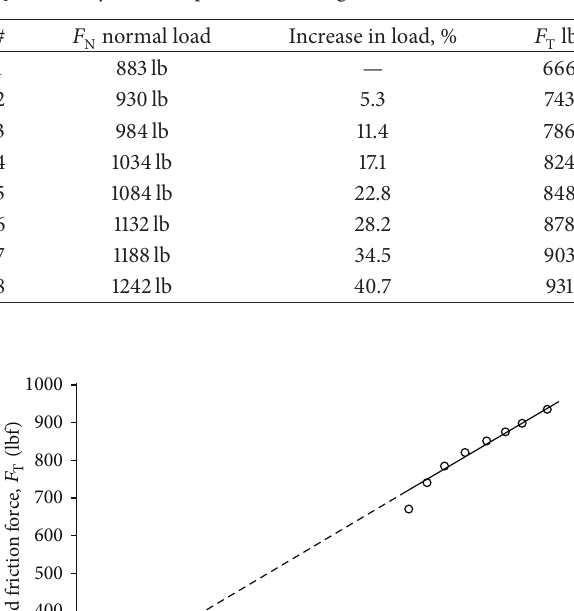
Table 4: Individual weights selected for use in controlling the ) applied to test tire during lockups and measured dynamic load ( 𝐹 N 𝐹